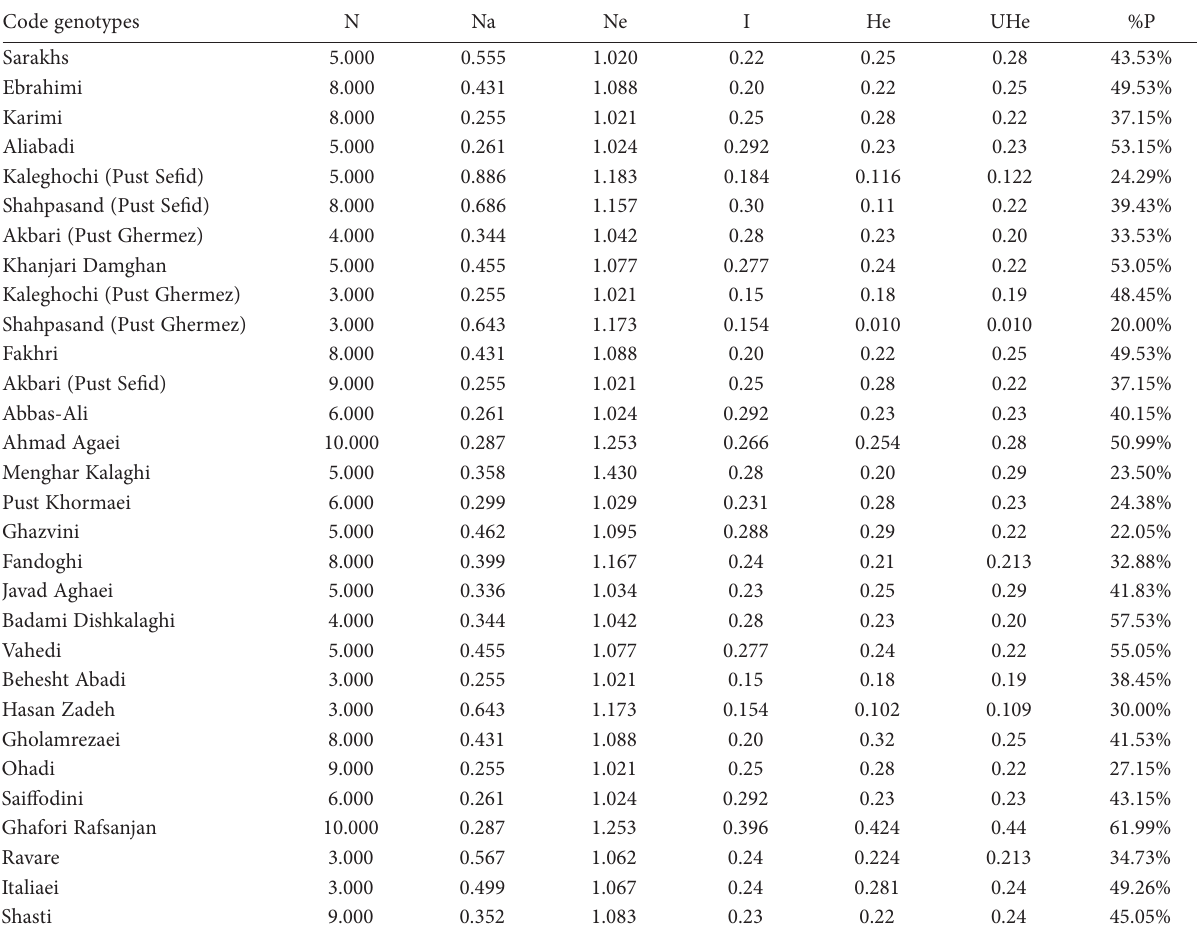
Table 3. Genetic diversity parameters in the studied populations of pistachio cultivars (N = number of samples, Na = Number of different alleles, Ne = number of effective alleles, I= Shannon’s information index, He = genetic diversity, UHe = unbiased gene diversity, P%= per- centage of polymorphism,